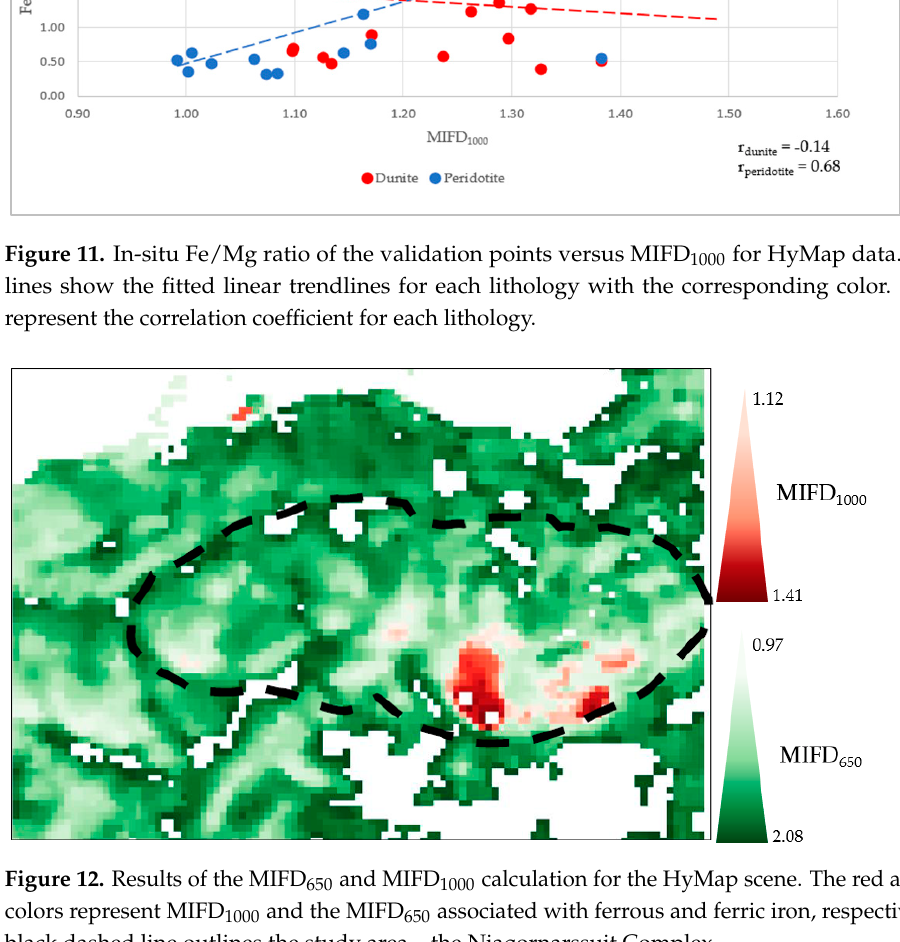
Figure 12. Results of the MIFD 650 and MIFD 1000 calculation for the HyMap scene. The red and green colors represent MIFD 1000 and the MIFD 650 associated with ferrous and ferric iron, respectively. The black dashed line outlines the study area—the Niaqornarssuit Complex.